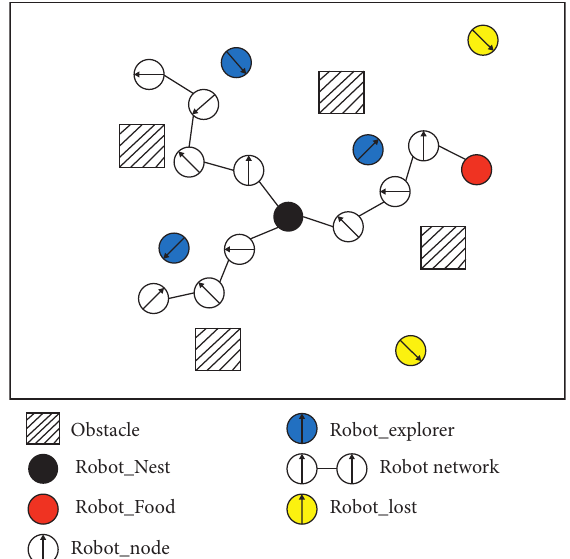
Figure 2: A network constructed by our control